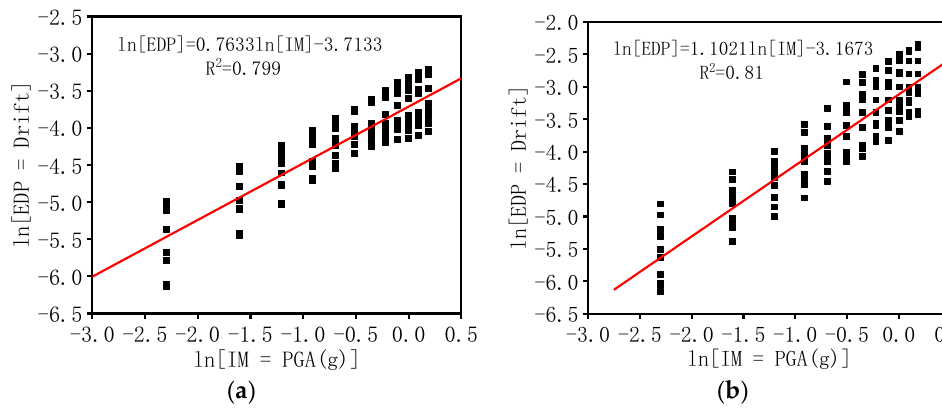
Figure 6. Relationship between ln[IM = PGA] and ln[EDP = Drift]: ( a ) CoSPSW, ( b ) SPSW.